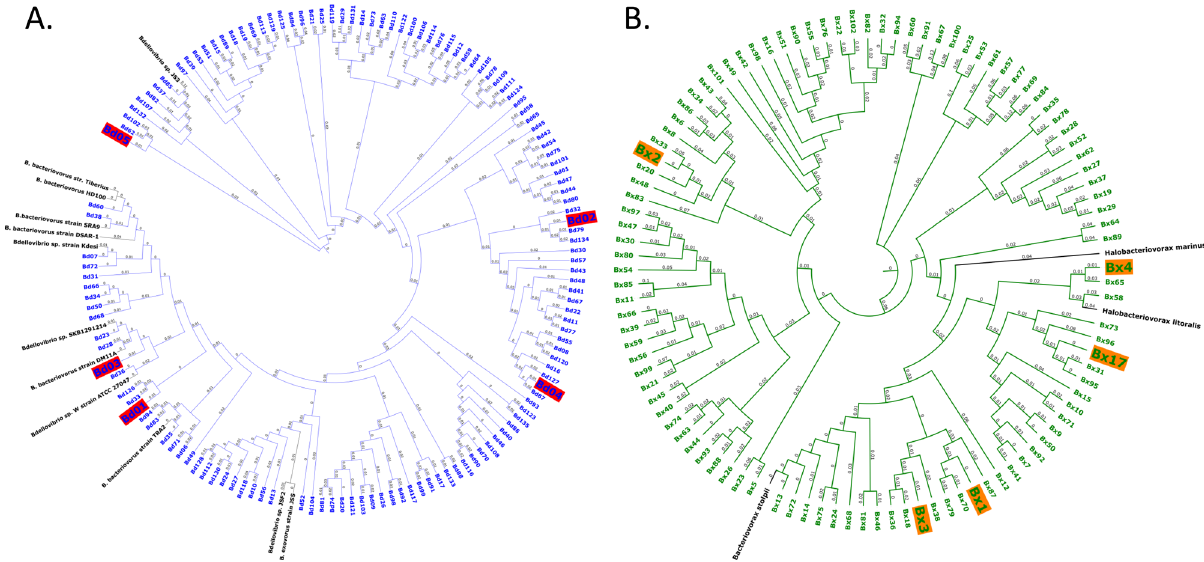
Fig. 1 Phylogenetic analysis of BALOs. Molecular phylogenetic analysis of the 100 most abundant 16S rRNA gene sequence-based OTUs of each of the two predatory bacterial families, Bdellovibrionales ( A ) (the Bd OTUs identi fi ed in this study are in blue fonts) and Bacteriovoracales ( B ) (the Bx OTUs identi fi ed in this study are in green fonts), using maximum likelihood. Distances (0 – 1) are written on the branches. The labelled OTUs are the fi ve most abundant OTUs of the predators in the different WWTPs.